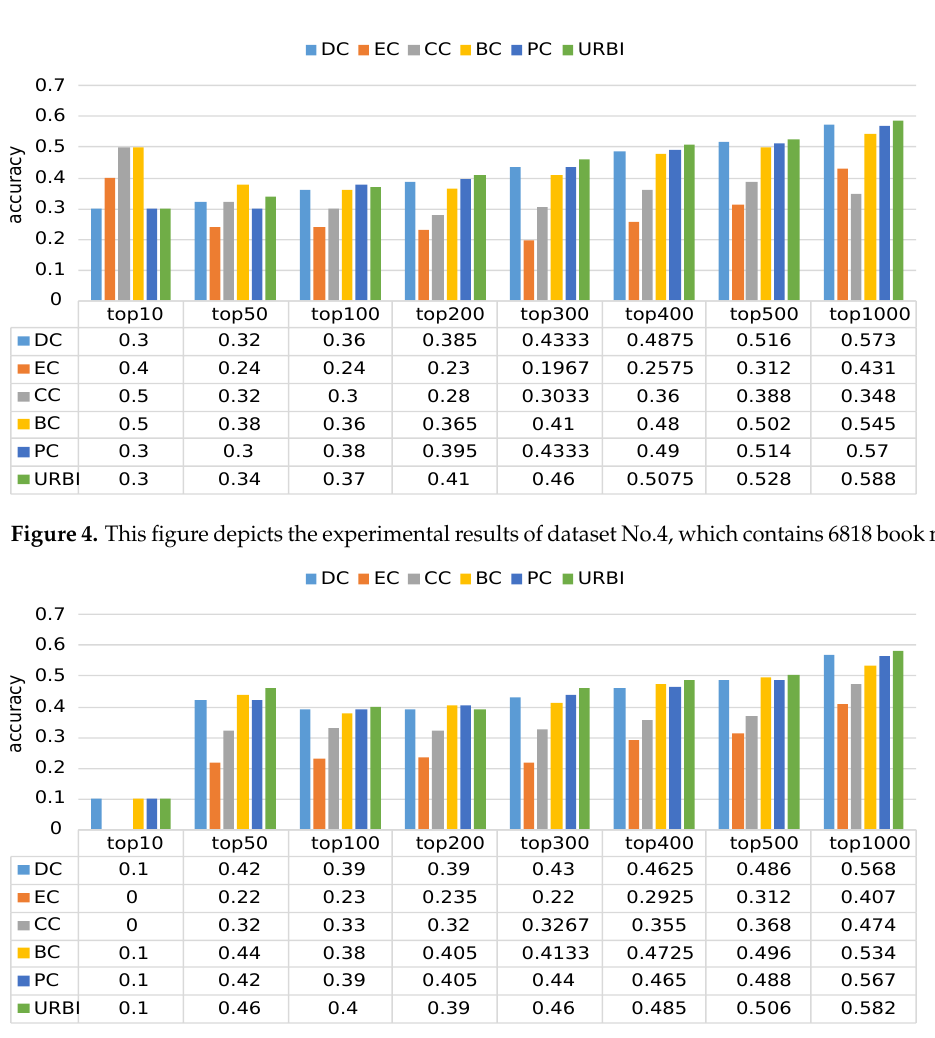
Figure 5. This figure depicts the experimental results of dataset No.5, which contains 7105 book nodes.